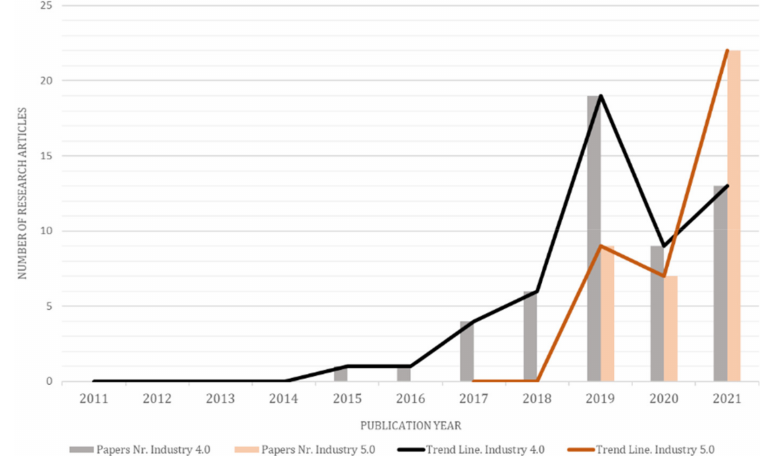
Figure 3. Publication trends.